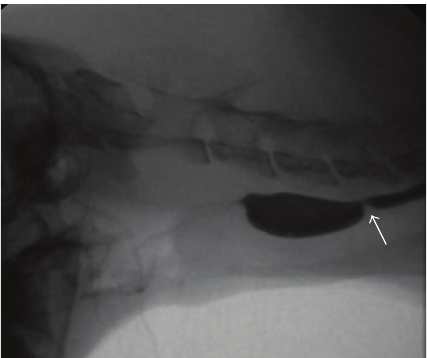
Figure 1: Fluoroscopic image from an esophagram performed in a cat with a history of vomiting, retching, and ptyalism. A focal circumferential area of stricture is noted at the level of C5 (white arrow) with dilation of the esophagus orad to the